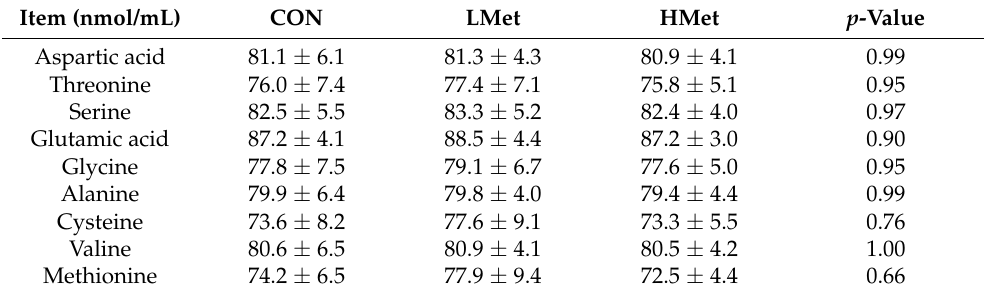
Table 4. Effect of methionine supplementation on apparent amino acid digestibility in sika deer. Item